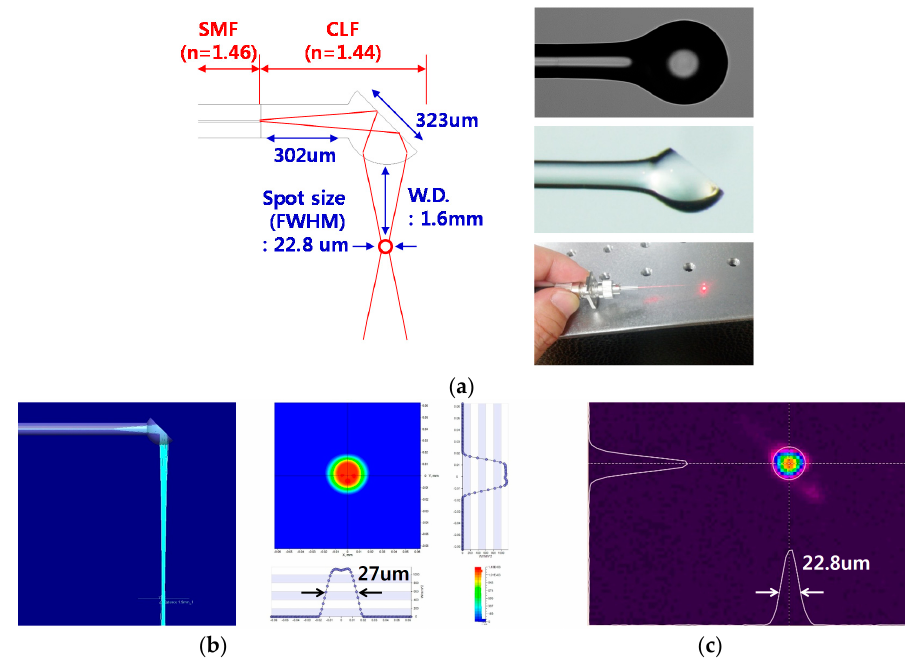
Figure 3. ( a ) Design and manufacture of the ball-lens fiber. ( b ) Simulation results for the